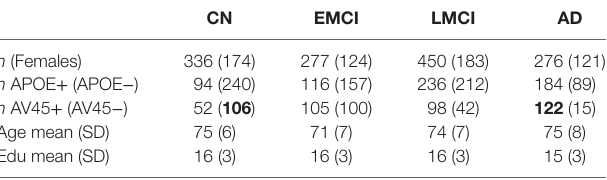
As in Table 1 , amyloid positivity was set at cortical mean AV45 SUVR ≥ 1.10 (28), prior to adjustment for covariates. Numbers in bold font indicate controls and patients (see text for details) used in our disease progression modeling.